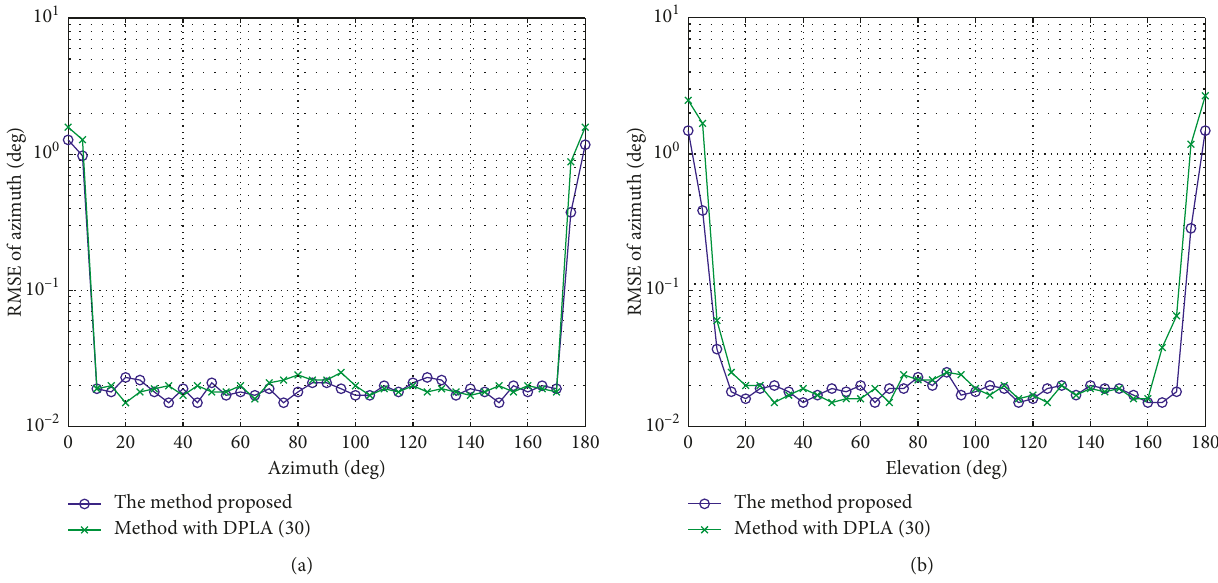
Figure 8: (a) RMSE estimated versus azimuth boundary region; (b) RMSE estimated versus elevation boundary